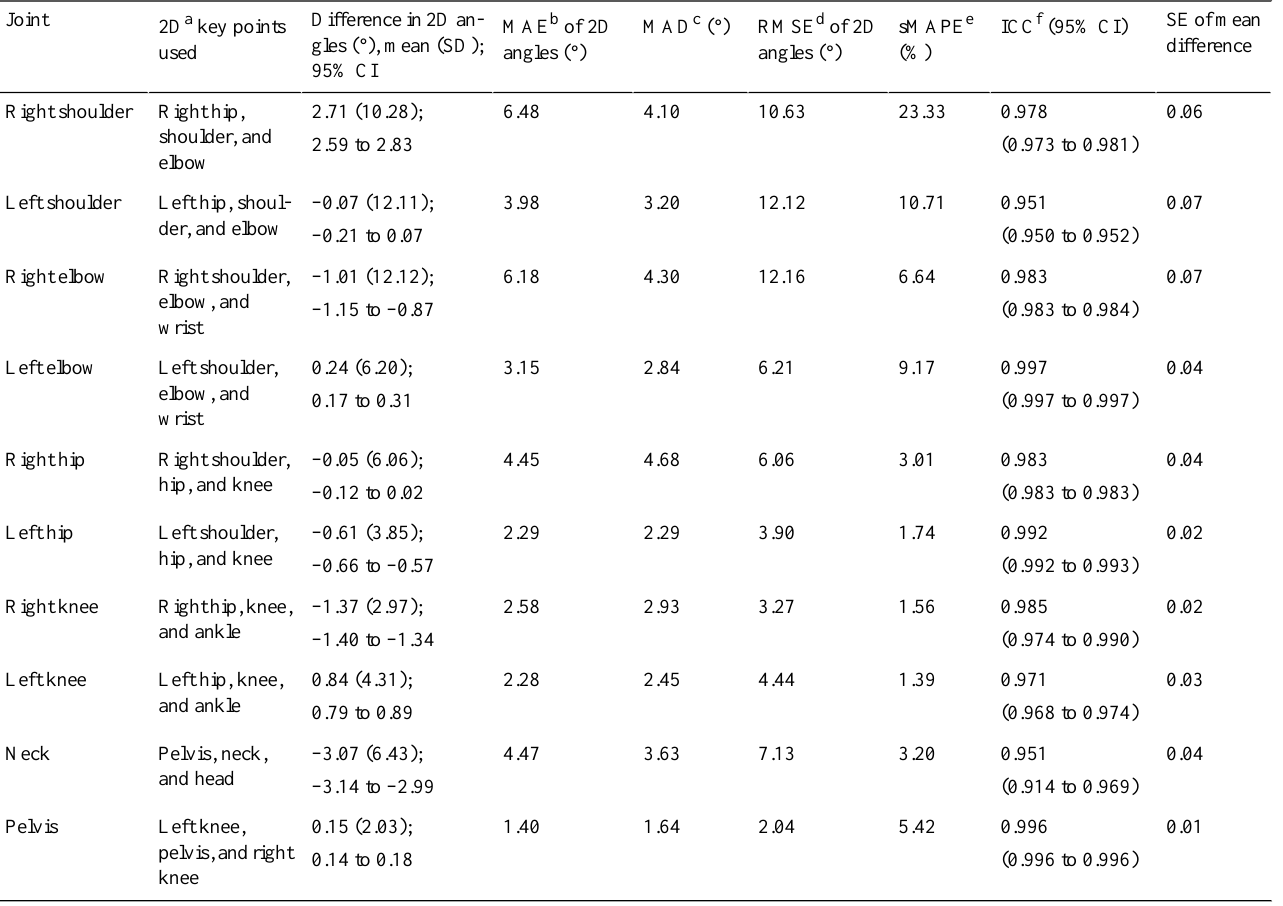
Table 1. Mean angle difference and ICC of Lindera-v2 and the Panoptic Studio data set for the joints